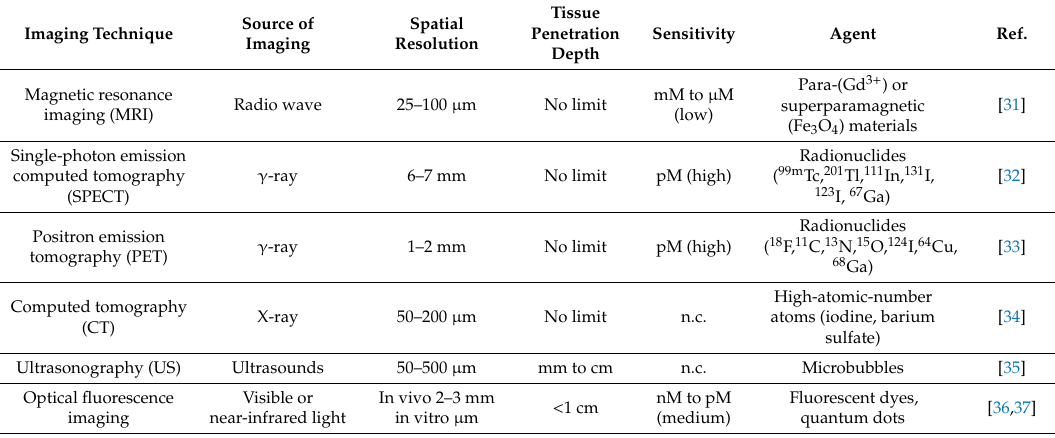
Table 2. Molecular imaging